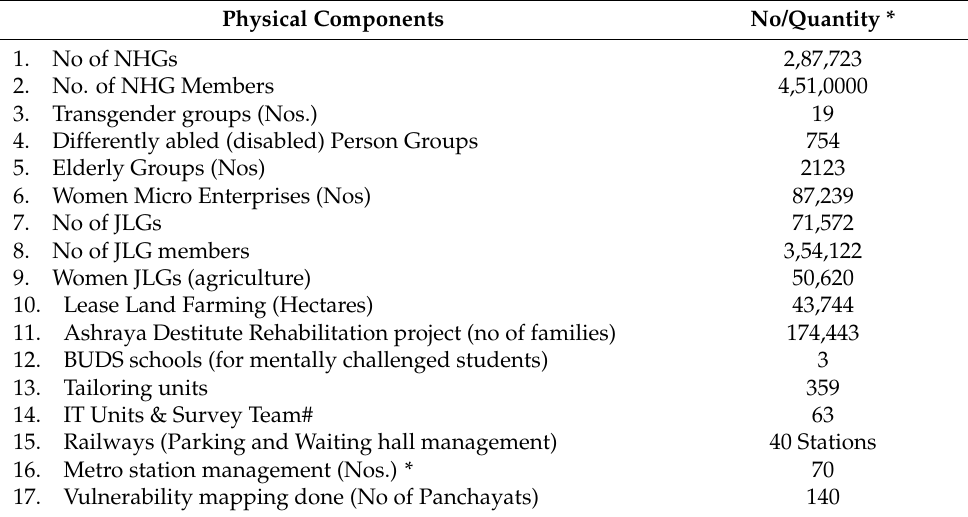
Table 2. Key components of Kudumbashree programme—Physical achievement, 2019–20.